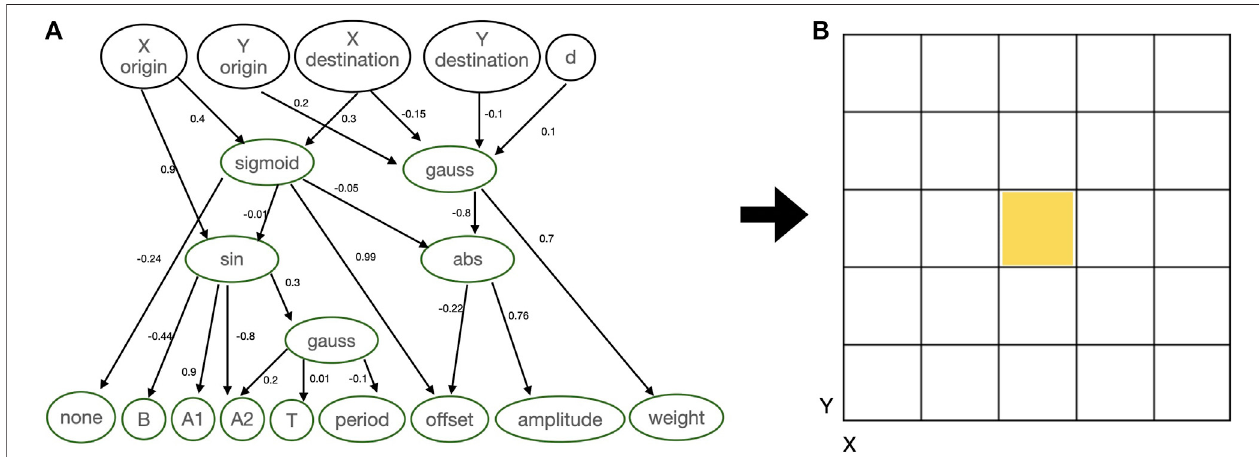
FIGURE2|(A) DidacticalexampleofCPPN:inputsarethecoordinatesofthesubstrate,whileoutputsareusedtode fi nemodulestobeplacedinthesubstrateand also the parameters of the controller. (B) Morphology substrate.